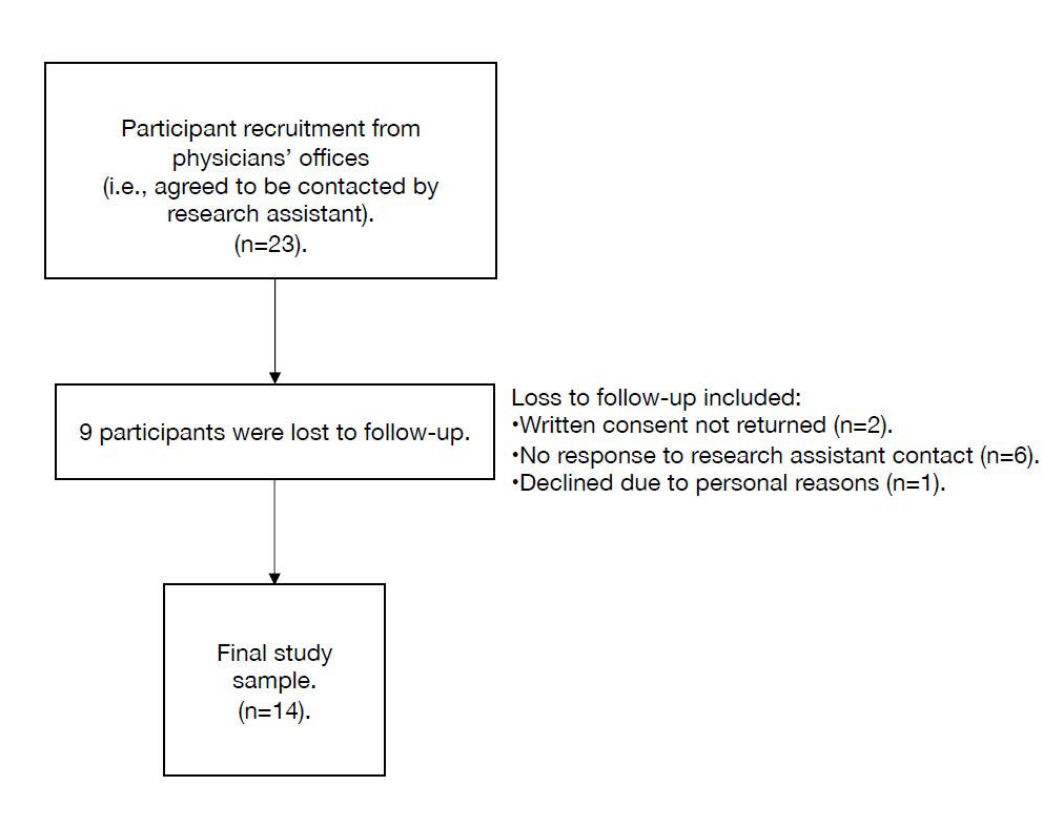
Figure 1. Participant flow